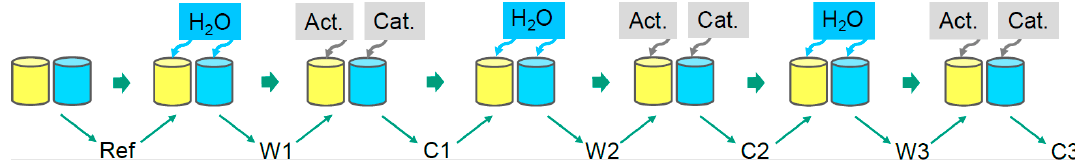
Figure 6. Order of water addition and compensation procedure.